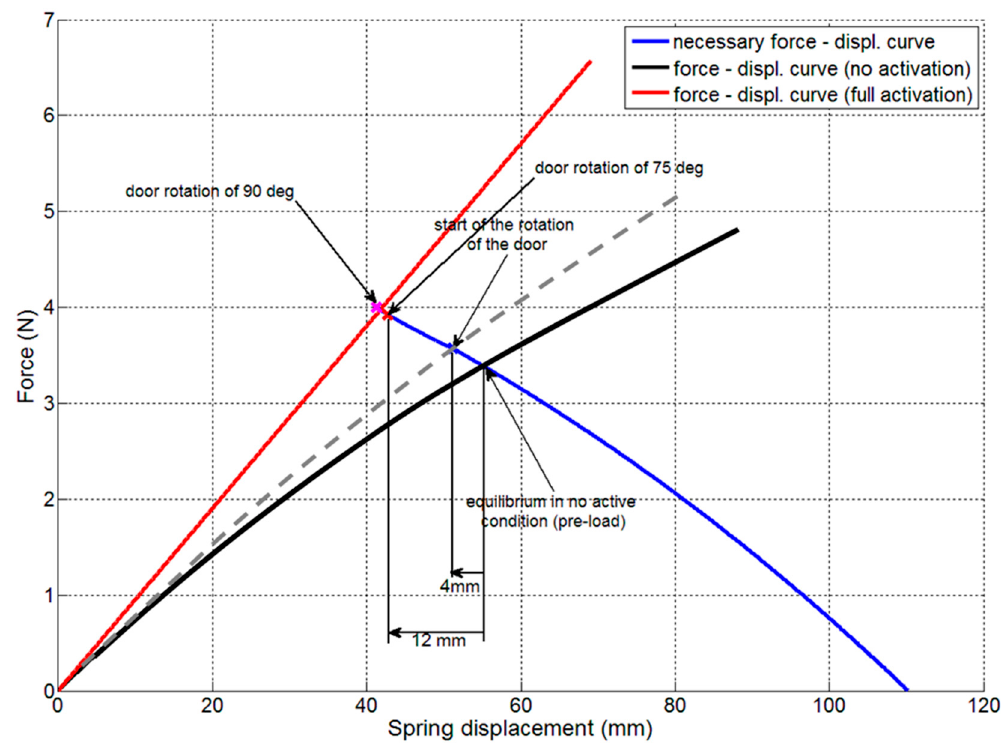
Figure 5. System working points; force displacement curve for the non-activated SMA spring (black); force displacement curve for the fully activated SMA spring (red); intermediate activation curve (dashed); elastic response of the system (blue)